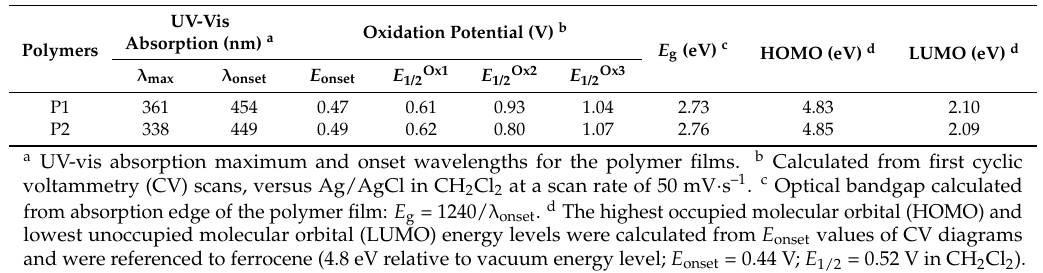
Figure 10. Spectroelectrochemistry of the electro-generated films of P2 (thickness: 170 ± 100 nm) on the ITO-coated glass substrate in 0.1 M Bu 4 NClO 4 /CH 2 Cl 2 at various applied potentials.